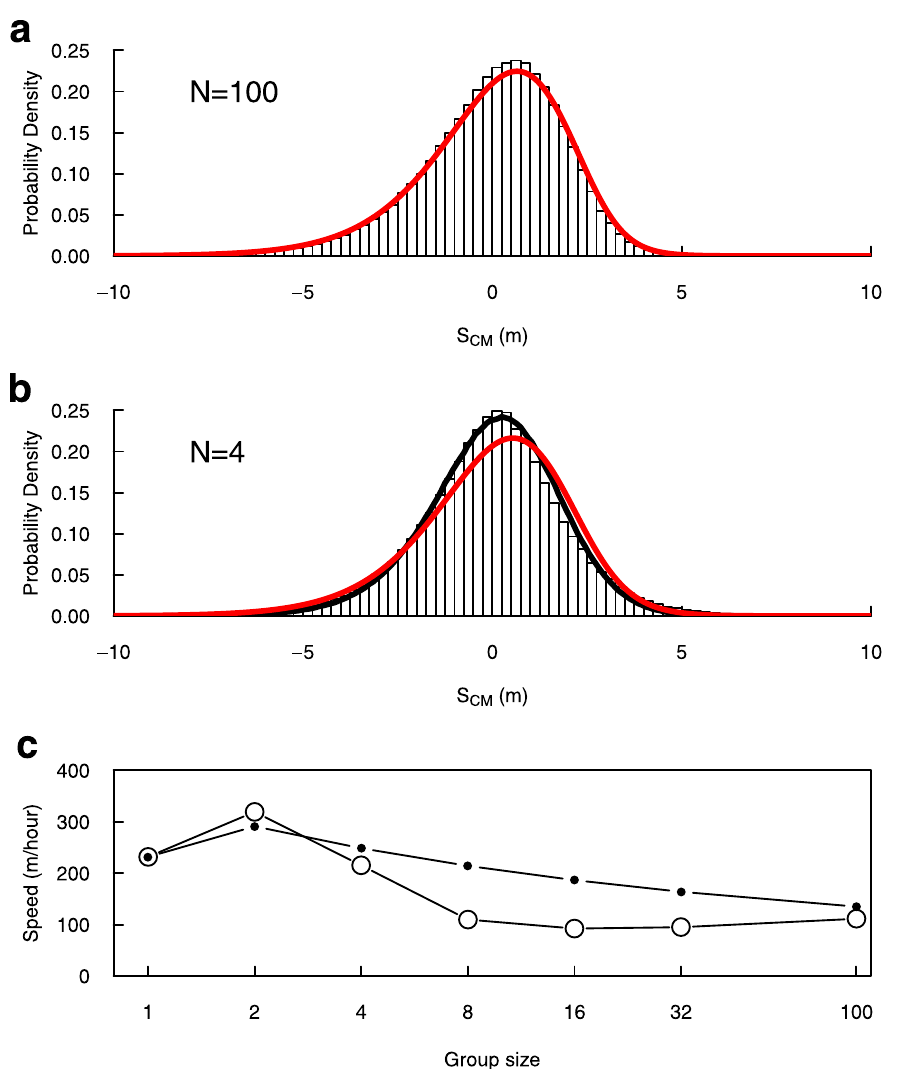
Fig 6. Density Model predictions vs. IBM predictions. (a) Histogram: statistics of presence around the center of mass of the group for N = 100, predicted from 300 IBM realisations; red line: numerical solution of Eqs 5 and 6 ( Δ t = 10 − 2 s). (b) Histogram: statistics of presence around the center of mass of the group for N = 4, predicted from 10 6 IBM realisations; red line: numerical solution of Eqs 5 and 6 ( Δ t = 10 − 2 s); black line: statistics of presence around the center of mass for groups of 4 positions sampled from the red curve, and applying the same procedure than the one used to obtain the histogram from IBM realisations (10 6 samples). (c) Predicted propagation speed depending on group size. Open dots: IBM predictions (error bars lie within the point size). Black dots: Density Model